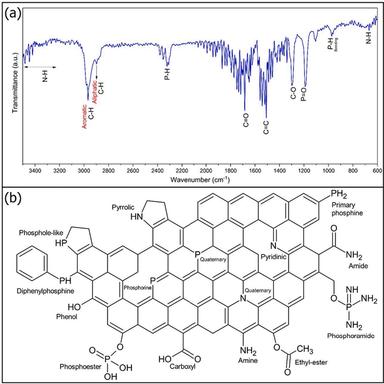
(a) FTIR spectrum of NP-CNTSs. The different bonds involved are attributed to oxygen, nitrogen, and phosphorus functionalities. (b) Possible functional groups and doping fashions containing carbon, nitrogen, oxygen, and phosphorus atoms are schematized in a graphene sheet.